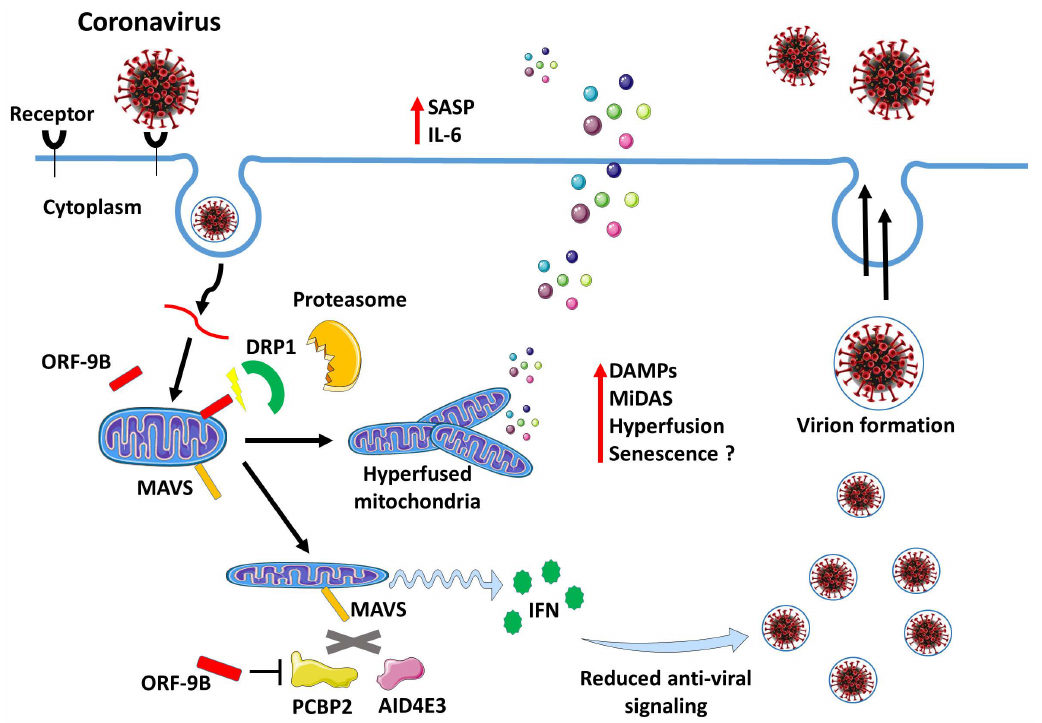
Figure 1. Modulation of mitochondrial dynamics upon CoV Infection. ORF-9b, a virulence factor of severe acute respiratory syndrome coronavirus (SARS-CoV), localizes to mitochondria and causes mitochondrial elongation by triggering ubiquitination and proteasomal degradation of dynamin-like protein (DRP1). Further, acting on mitochondria ORF-9b targets the mitochondrial-associated adaptor molecule MAVS signalosome by usurping poly(C)-binding protein 2 (PCBP2) and the HECT domain E3 ligase (AID4E3) to trigger the degradation of MAVS. This reduces host cell interferon responses